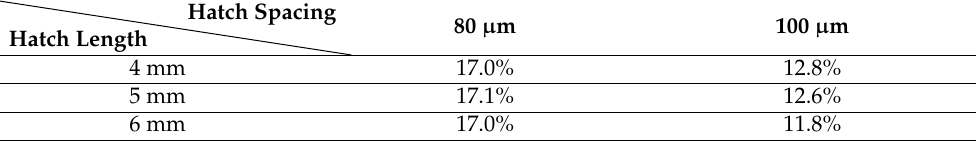
Table 1. Mean crystalline volume fraction in control